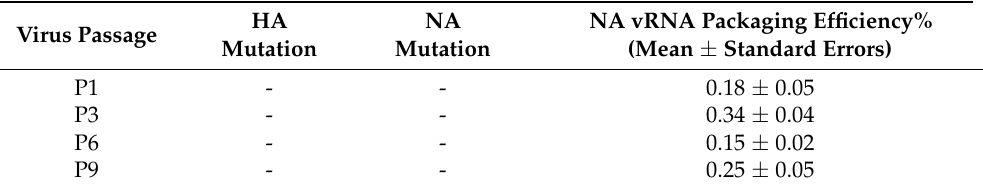
Table 1. Summary of nucleotide mutations in the HA and NA genes and the packaging efficiency of NA vRNA in the 20/13repNA virus following nine serial passages in chicken embryonated eggs. The dash symbol (-) indicates the absence of specific mutations. Virus